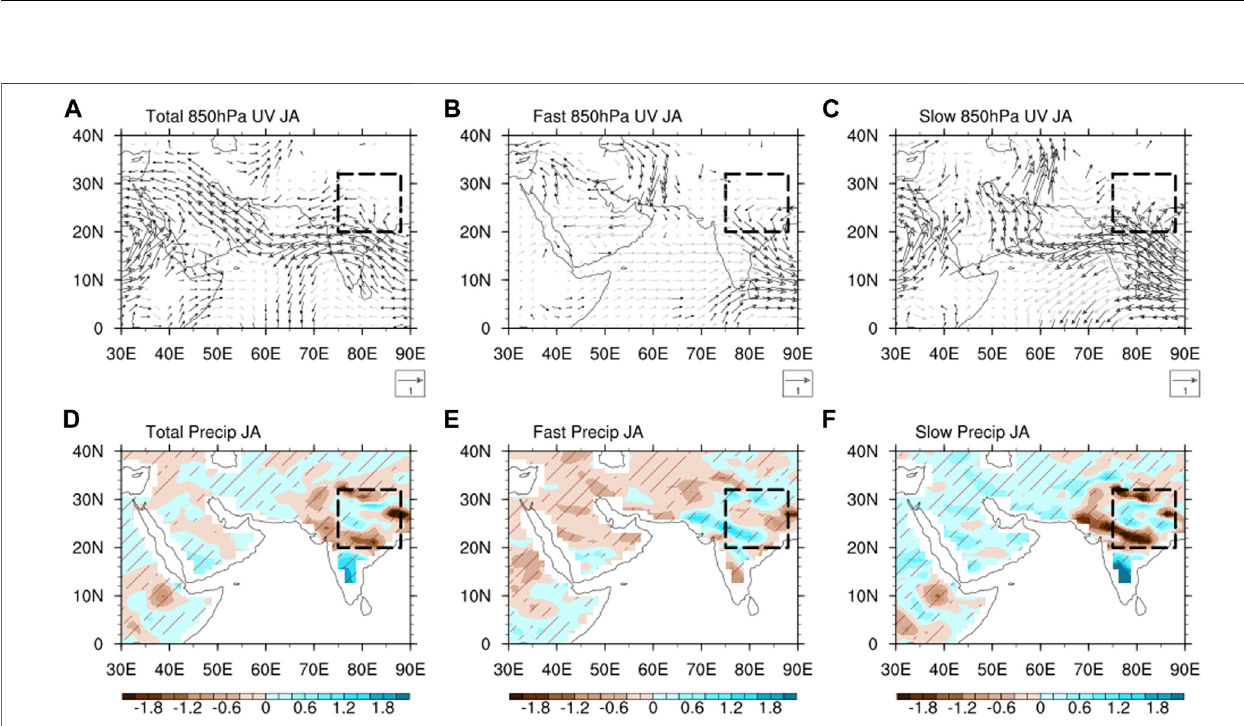
Frontiers in Environmental Science |